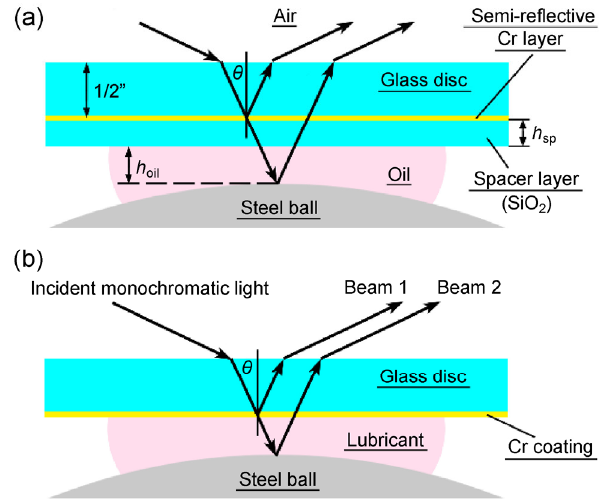
Fig. 5 Sketch of improved optical interference techniques; (a) space layer technique proposed by Guanteng and Spikes